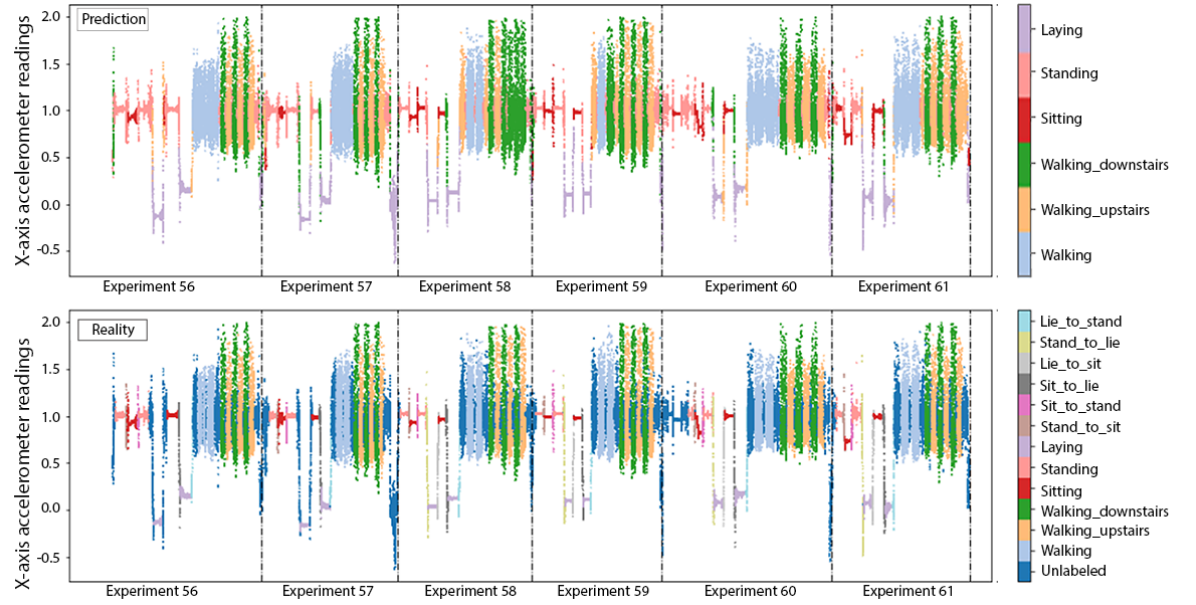
Figure 6. Instantaneous predictions using greedy Gaussian segmentation (top row) and ground truth (bottom row) from the 6 test experiments in the human activity recognition using smartphones dataset.